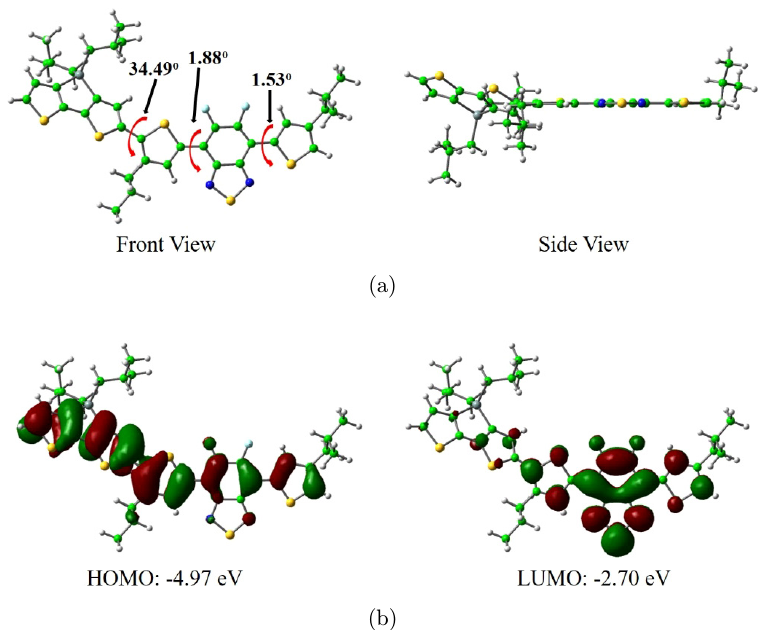
Fig. 3. (a) The front and side views of energy minimum conformations of the PDTSDTBT. (b) The calculated HOMO and LUMO energy levels of PDTSDTBT. Color code: green (C), white (H), blue (N), yellow (S) and light blue (F).